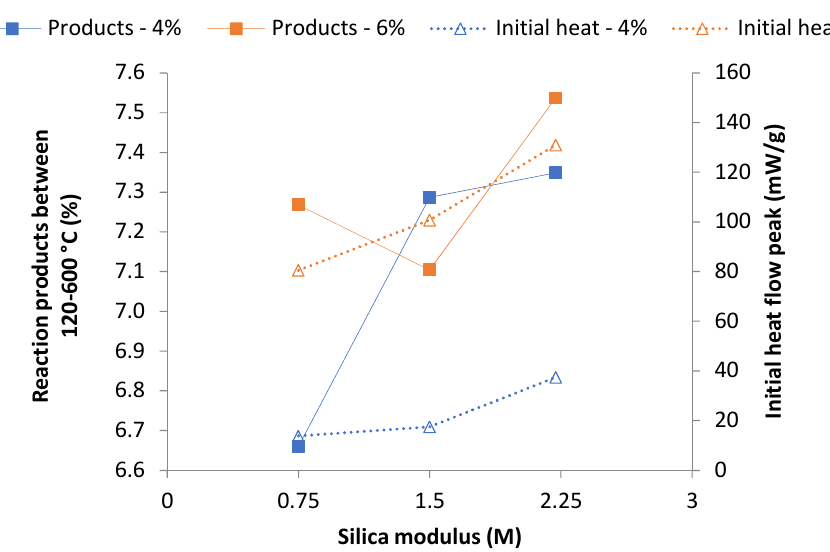
Figure 14. Influence of activator parameters on the relationship between the reaction products and the initial heat release (blue: 4% of Na 2 O; orange: 6% of Na 2 O; squares: reaction products; triangles: initial heat release).